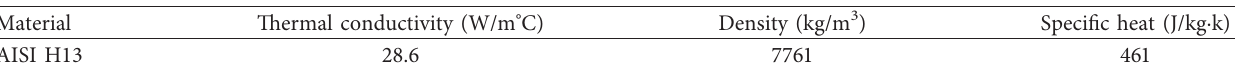
Table 4: Properties of H13 [26].